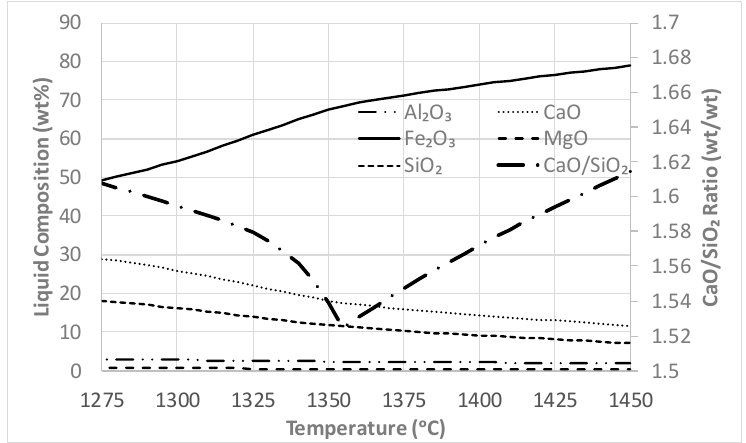
Figure 19. Variation in liquid composition with temperature for the base case assuming chemical equilibrium is achieved.